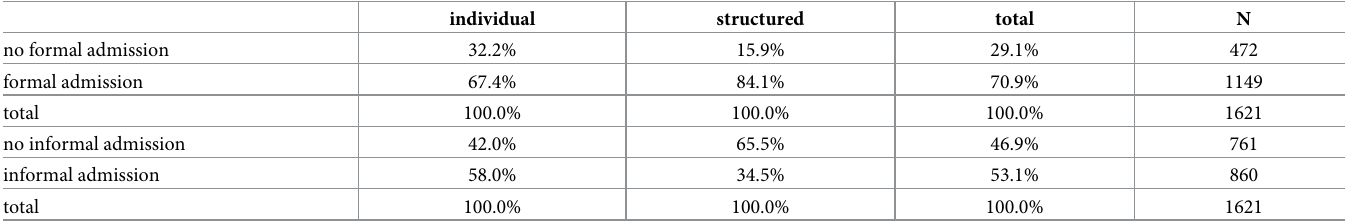
Table 2. Formal and informal